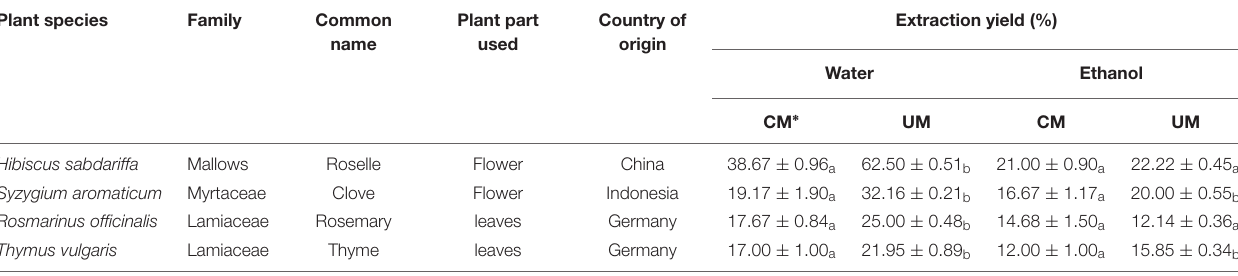
TABLE 1 | Plant species used in this study and their extraction yield percentage by conventional and ultrasound method. Plant species